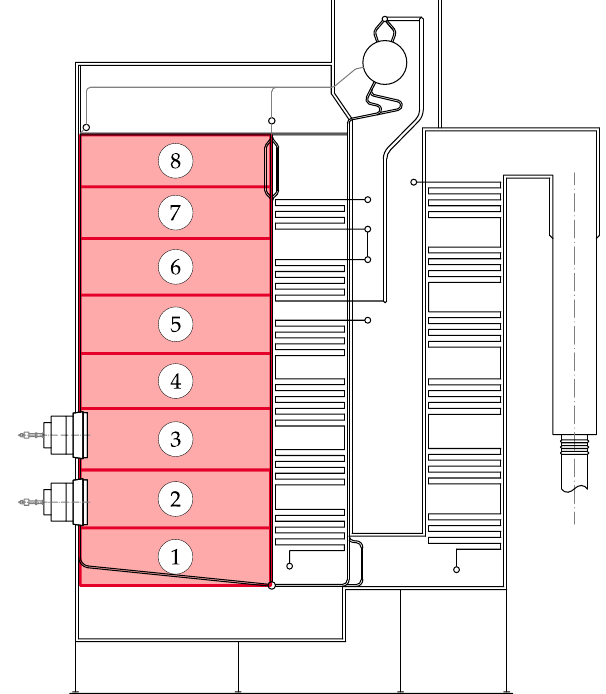
Figure 6. Radiant chamber of the discussed steam boiler discretised via the AMPF